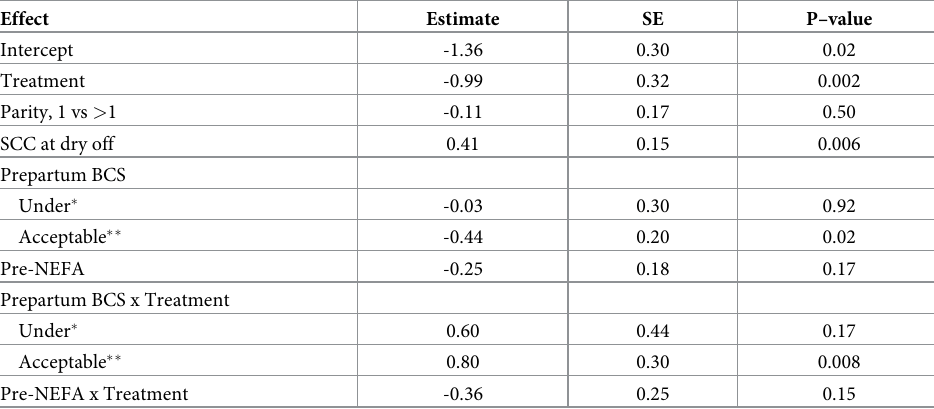
Table 2. Occurrence of a first case of clinical mastitis during the first 30 days in